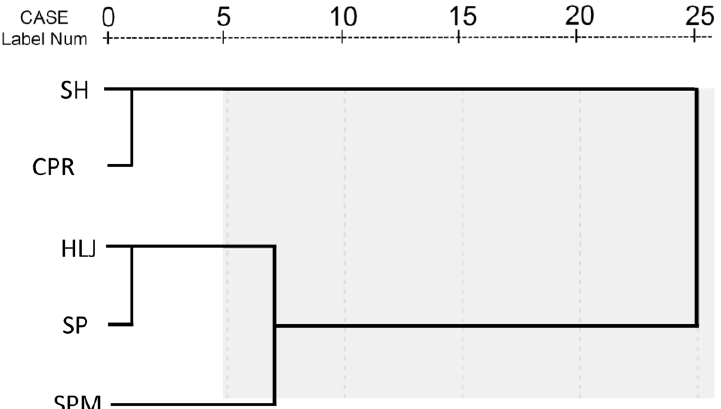
Figure 1. The clustering relationship among the five species of common carp. The cluster analysis was performed on the average of the ratios of eight traits and body lengths using the SPSS software.